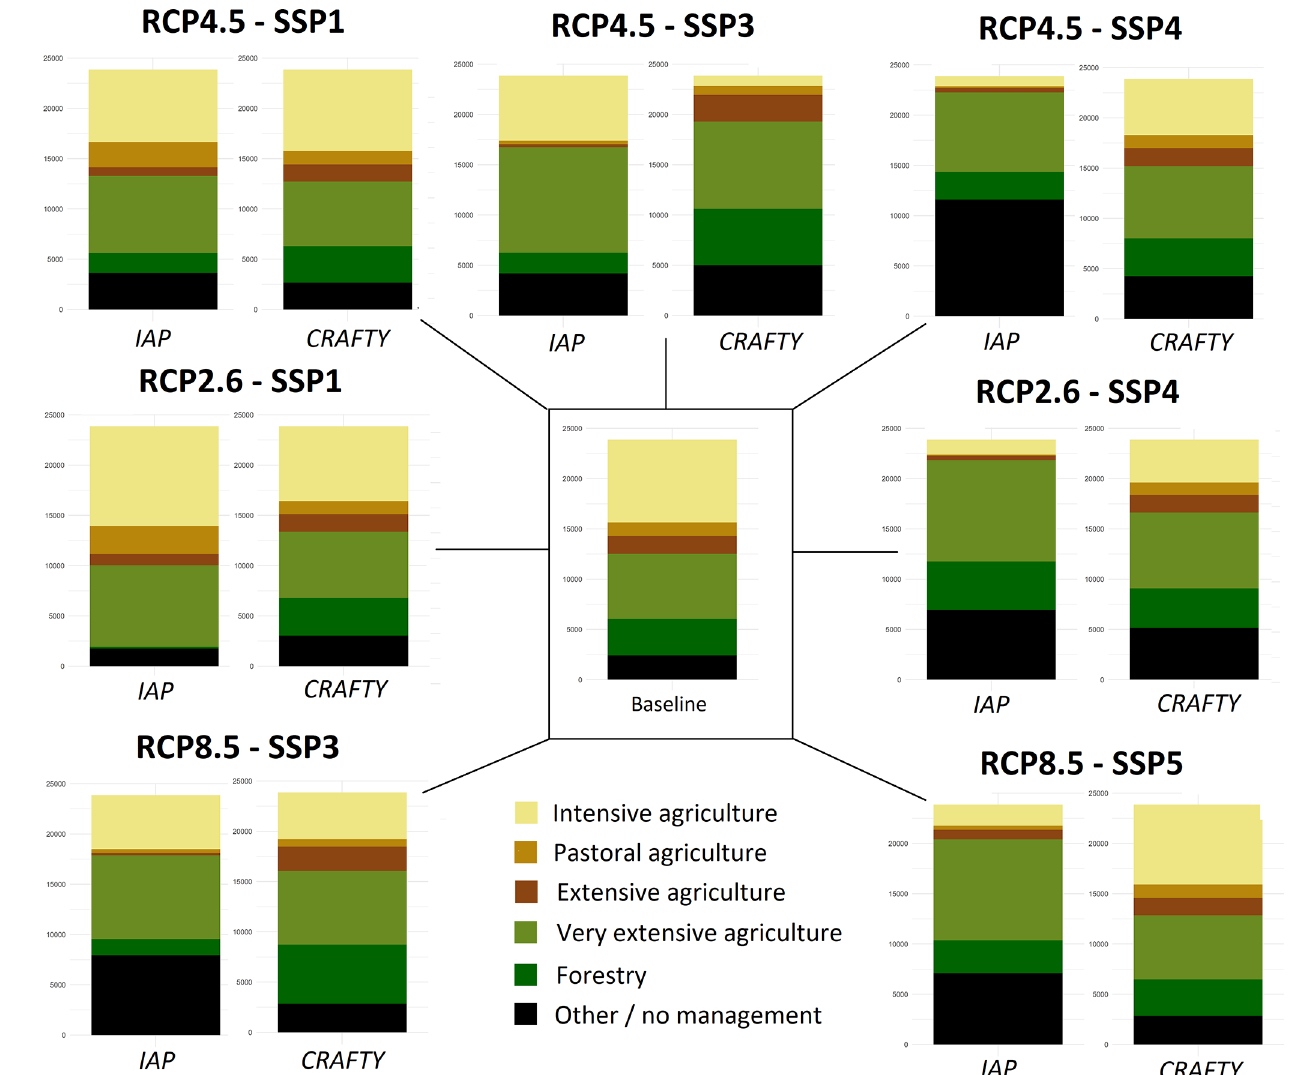
Figure 2. Simulated land use classes for each scenario in each model in the mid-2080s. Bars show the number of cells occupied by each class out of the total number of 23871 cells ( y axes). Climate scenarios (RCPs) are arranged in rows. The baseline is identical in both models and is therefore only shown